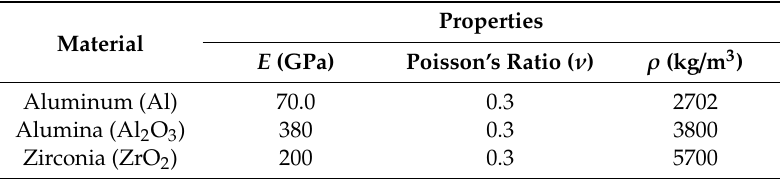
Figure 1. Geometry of a functionally graded material (FGM) plate and coordinates: ( a ) top view, ( b ) side view. Table 1. Material properties of the FGM ingredients.